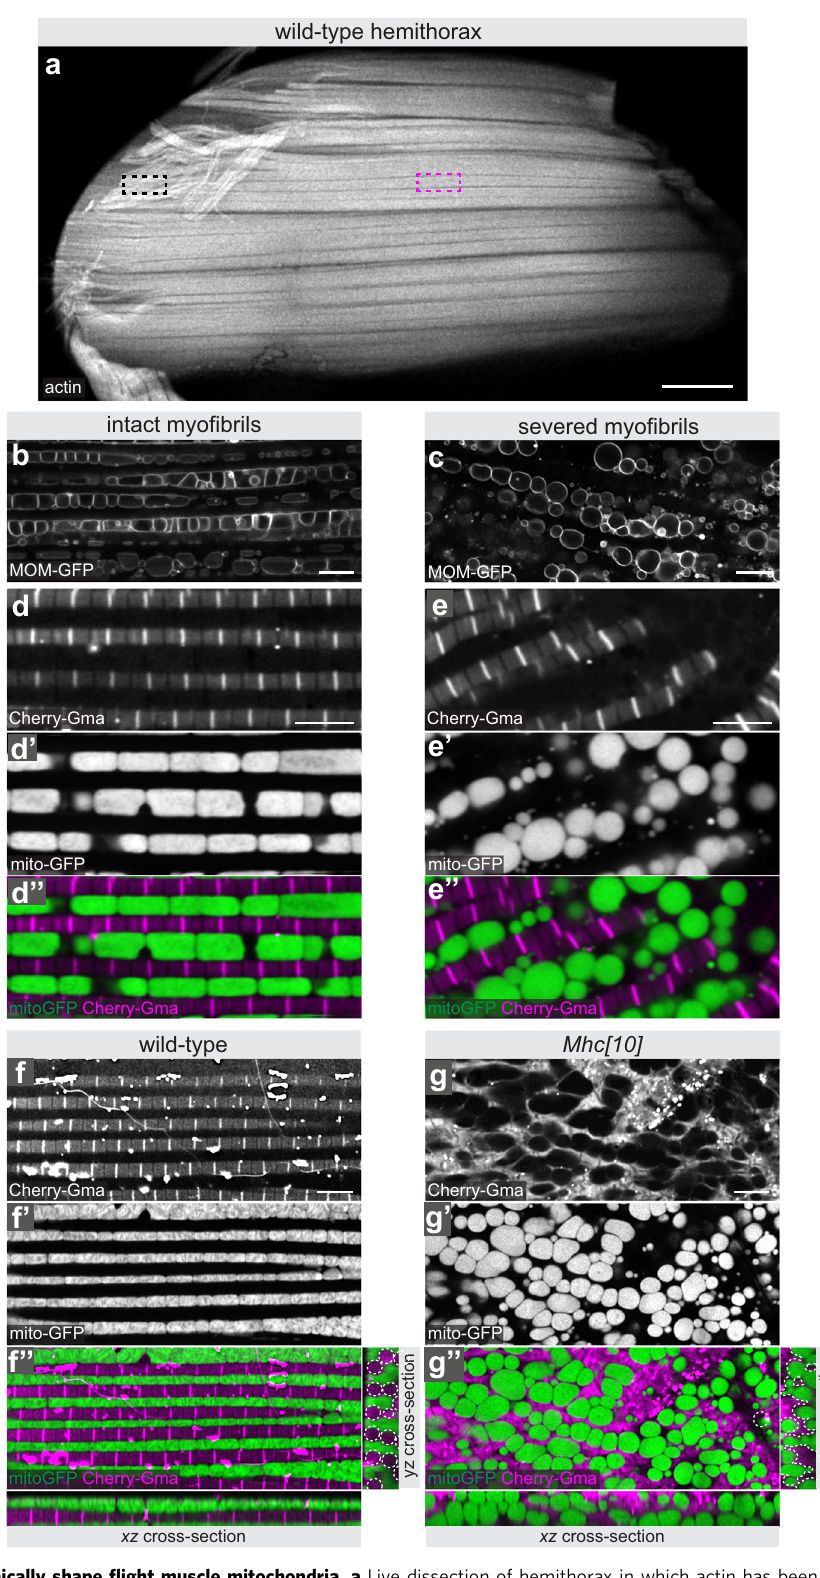
Fig. 3 Myo fi brils mechanically shape fl ight muscle mitochondria. a Live dissection of hemithorax in which actin has been labelled with Cherry-Gma expressed with Mef2- GAL4. Black rectangle indicates a severed area, in which myo fi brils have been mechanically cut, magenta rectangle marks an intact area. b – e High magni fi cation confocal sections of intact ( b , d ) and severed areas ( c , e ) of un fi xed fl ight muscles in which mitochondria have been labelled with MOM-GFP (expressed with Mef2 -GAL4) ( b , c ) or with mito-GFP together with Cherry-Gma to label myo fi brils ( d , e ). Note the spherical mitochondria shape and their disengagement from the myo fi brils in the severed areas. f , g High magni fi cation of un fi xed fl ight muscle from wild type ( f ) or Mhc[10] mutant ( g ) adults genetically labelled with Cherry-Gma to label myo fi brils (expressed with Mef2 -GAL4) ( f , g ) and mito-GFP to label mitochondria ( f ′ , g ′ ). Note how similar the rounded Mhc[10] mitochondria ( g ′ ) are to the ones in severed myo fi brils in e ′ . Scale bars are 100 µ m ( a ) and 5 µ m ( b – g